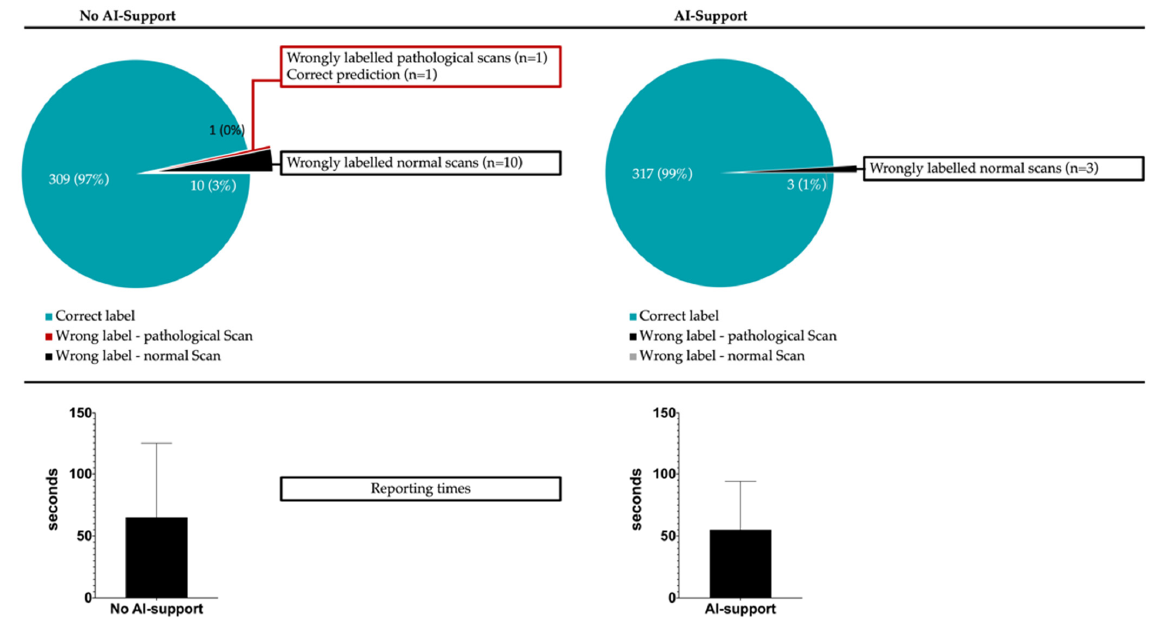
Figure 3. Given is the classification completeness with/without AI-support (upper panel). Patient- level misclassification into “normal” or ”pathological” could be significantly reduced from 11/320 cases to 3/320 cases ( p < 0.0001) once AI support was available. The lower panel gives the mean (± standard deviation) reporting time per scan with (54.9 ± 7.1 s) and without (65.1 ± 8.9 s) AI support ( p < 0.0001).